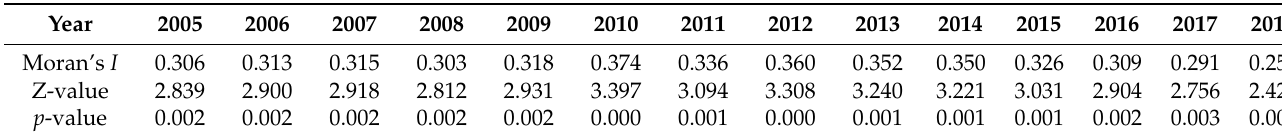
Table 2. Global Moran’s I ndex of DVI in China from 2005 to 2018.